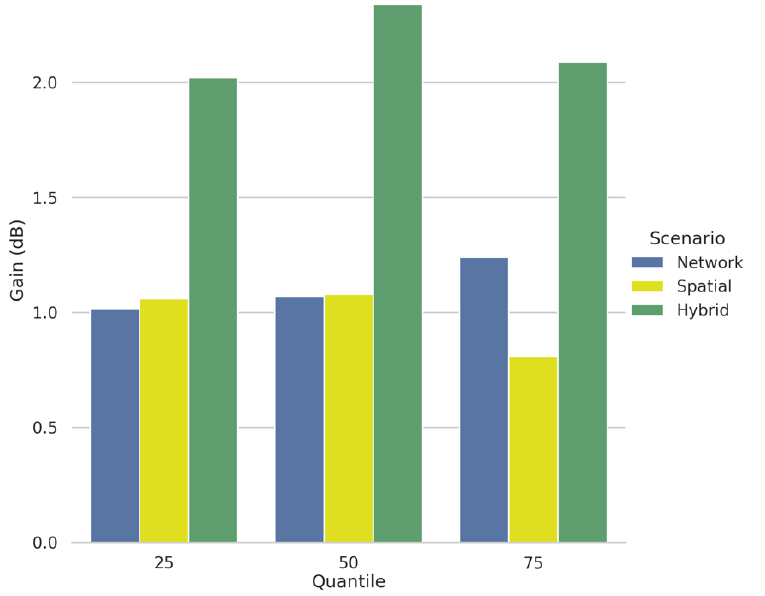
Figure 10. Comparison between the different algorithms ’ improvement vs. the baseline for RSRP gain (dB).